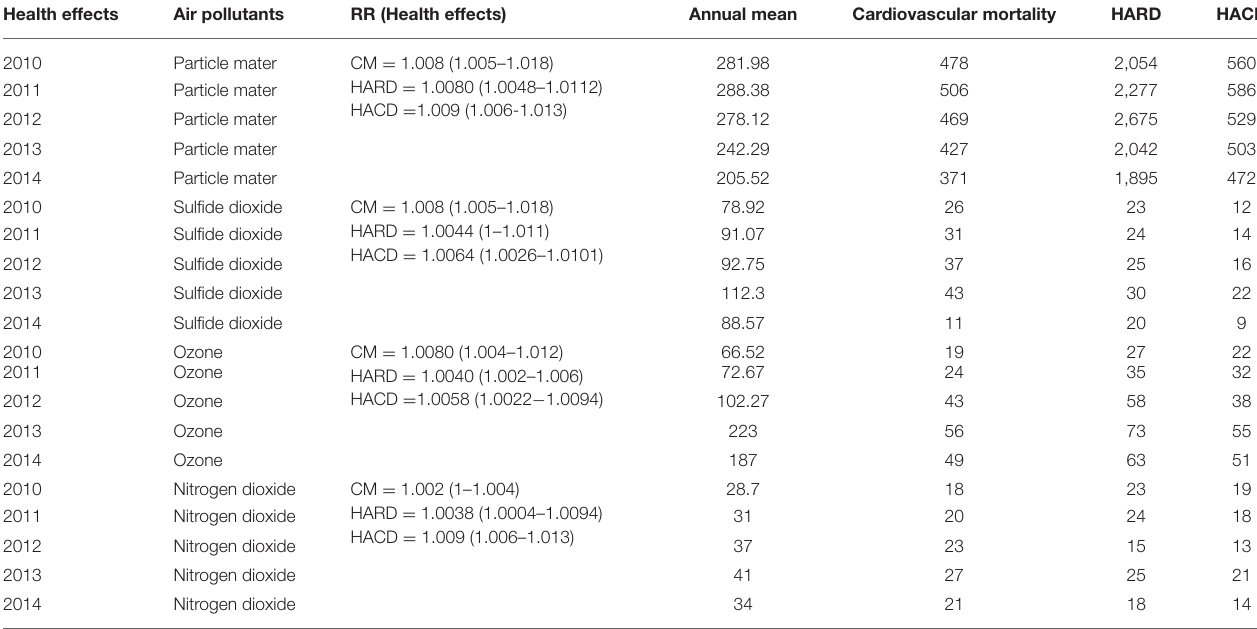
TABLE 1 | Criteria air pollutants concentrations ( µ g/m 3 ) and Health effects assessment of CAP on Ahvaz megacity inhabitants,